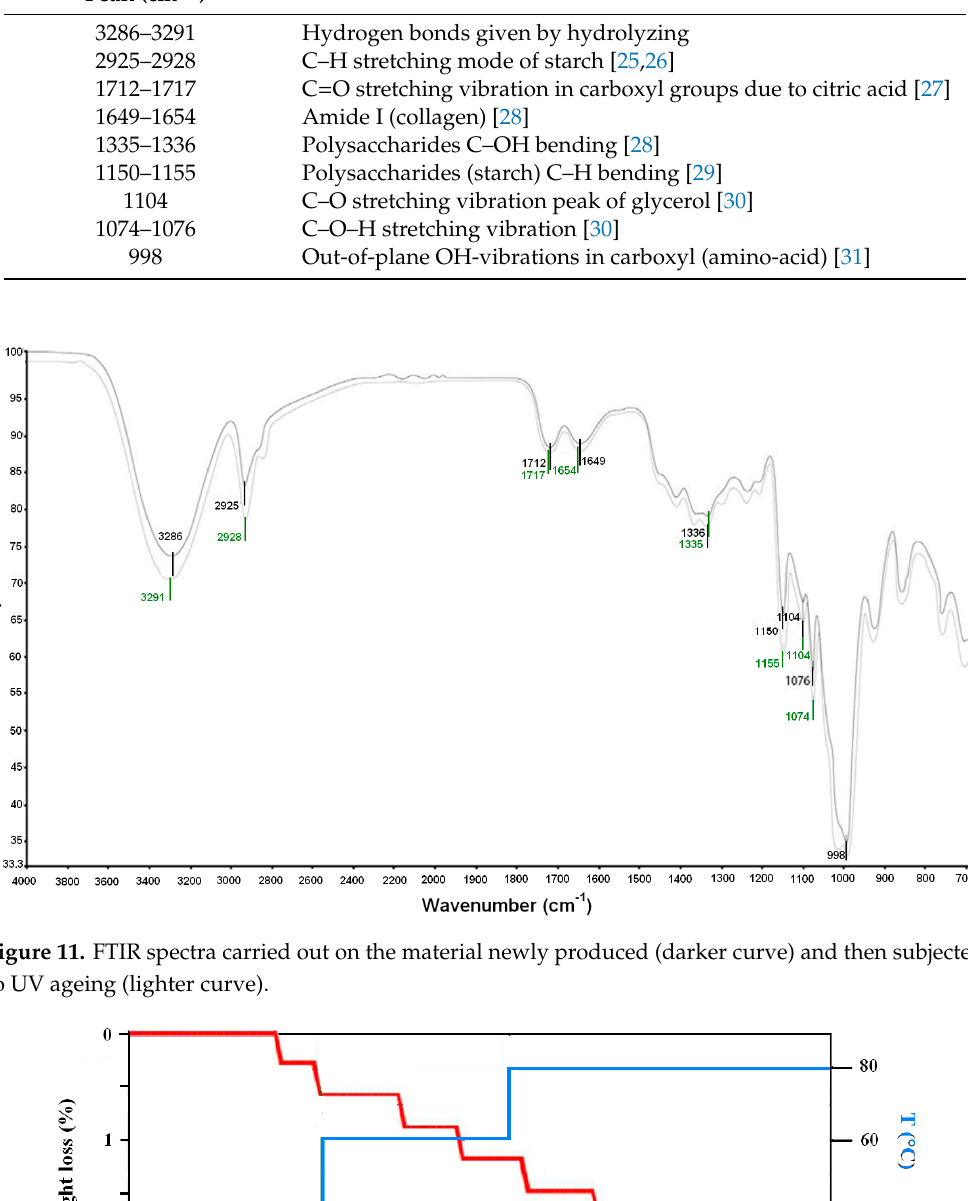
Figure 12. Weight loss of the material during heating up to 80 °C.